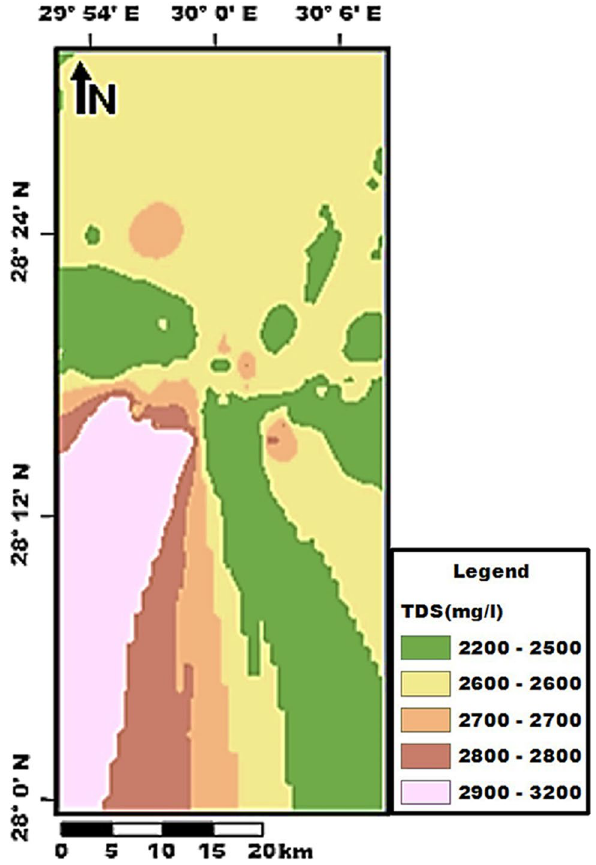
Fig. 6 Spatial distribution of total dissolved solids (TDS mg/l) in the new development